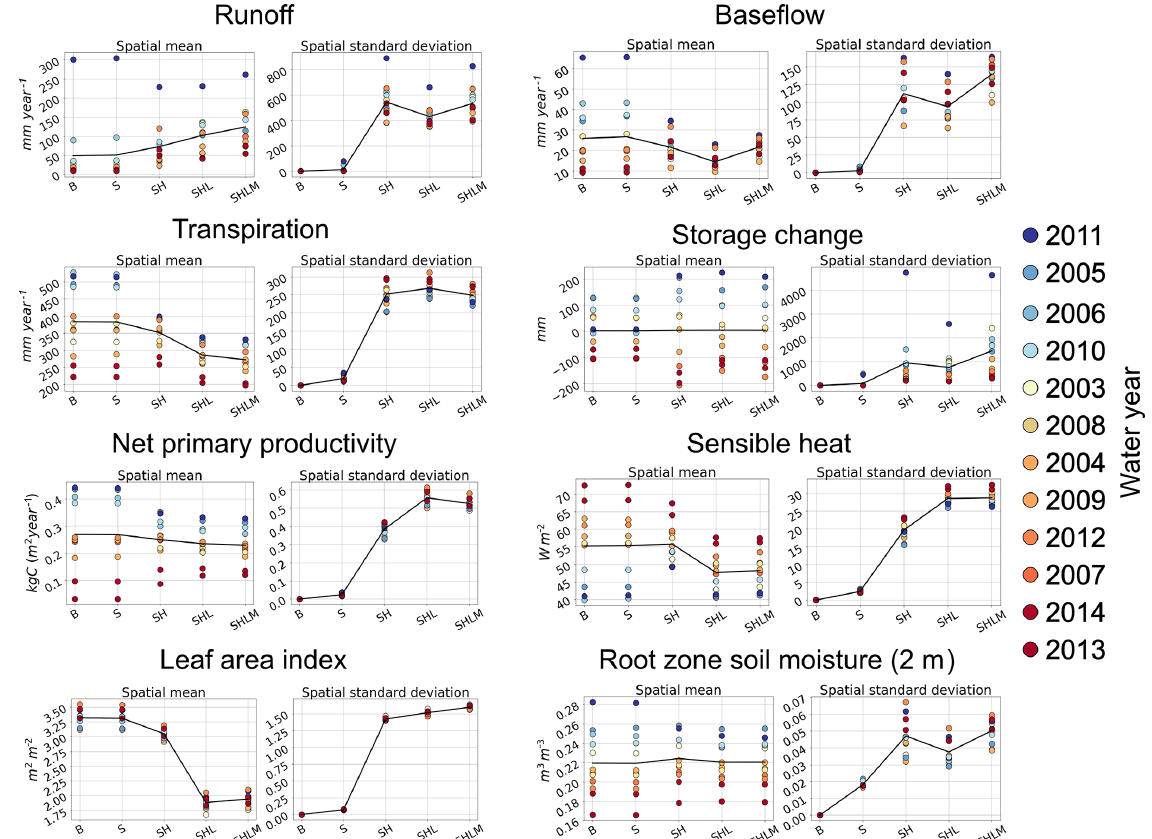
Figure 11. Comparison of the model experiments in Table 2. For each experiment, the spatial mean and spatial standard deviation for all water years between 2003 and 2014 are plotted for a suite of states and fluxes. The corresponding values for each water year are color-coded according to their precipitation. The black line shows the annual mean.